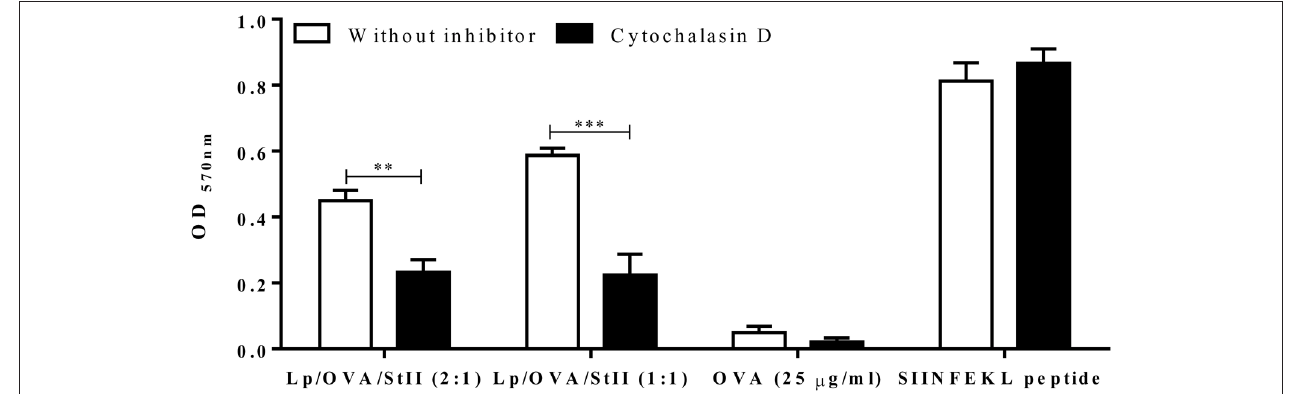
FIGURE 3 | Cytochalasin D inhibits antigen cross-presentation induced by StII co-encapsulated with OVA into liposomes. Bone marrow-derived macrophages (BM-M 8 s) from C57BL/6 mice were pre-incubated or not with 10 µ M cytochalasin D for 30min before stimulation. Next, the cells were stimulated with OVA co-encapsulated with StII into liposomes containing DPPC and Chol in 2:1 or 1:1 ratios [Lp/OVA/StII (2:1) or Lp/OVA/StII (1:1)] at final concentrations of 0.8 µ g/ml and 0.1 µ g/ml of each protein, respectively in the presence or absence of the inhibitor. Cells stimulated with 25 µ g/ml OVA in soluble form and 10nM of SIINFEKL peptide in similar conditions were used as controls. After incubation with the stimuli, cells were washed and co-cultured with B3Z CD8 + T cells. β -galactosidase activity of the B3Z cells was assessed by a colorimetric assay. Mean ± SEM of OD 570nm of two independent experiments are shown. Statistical analysis was performed with